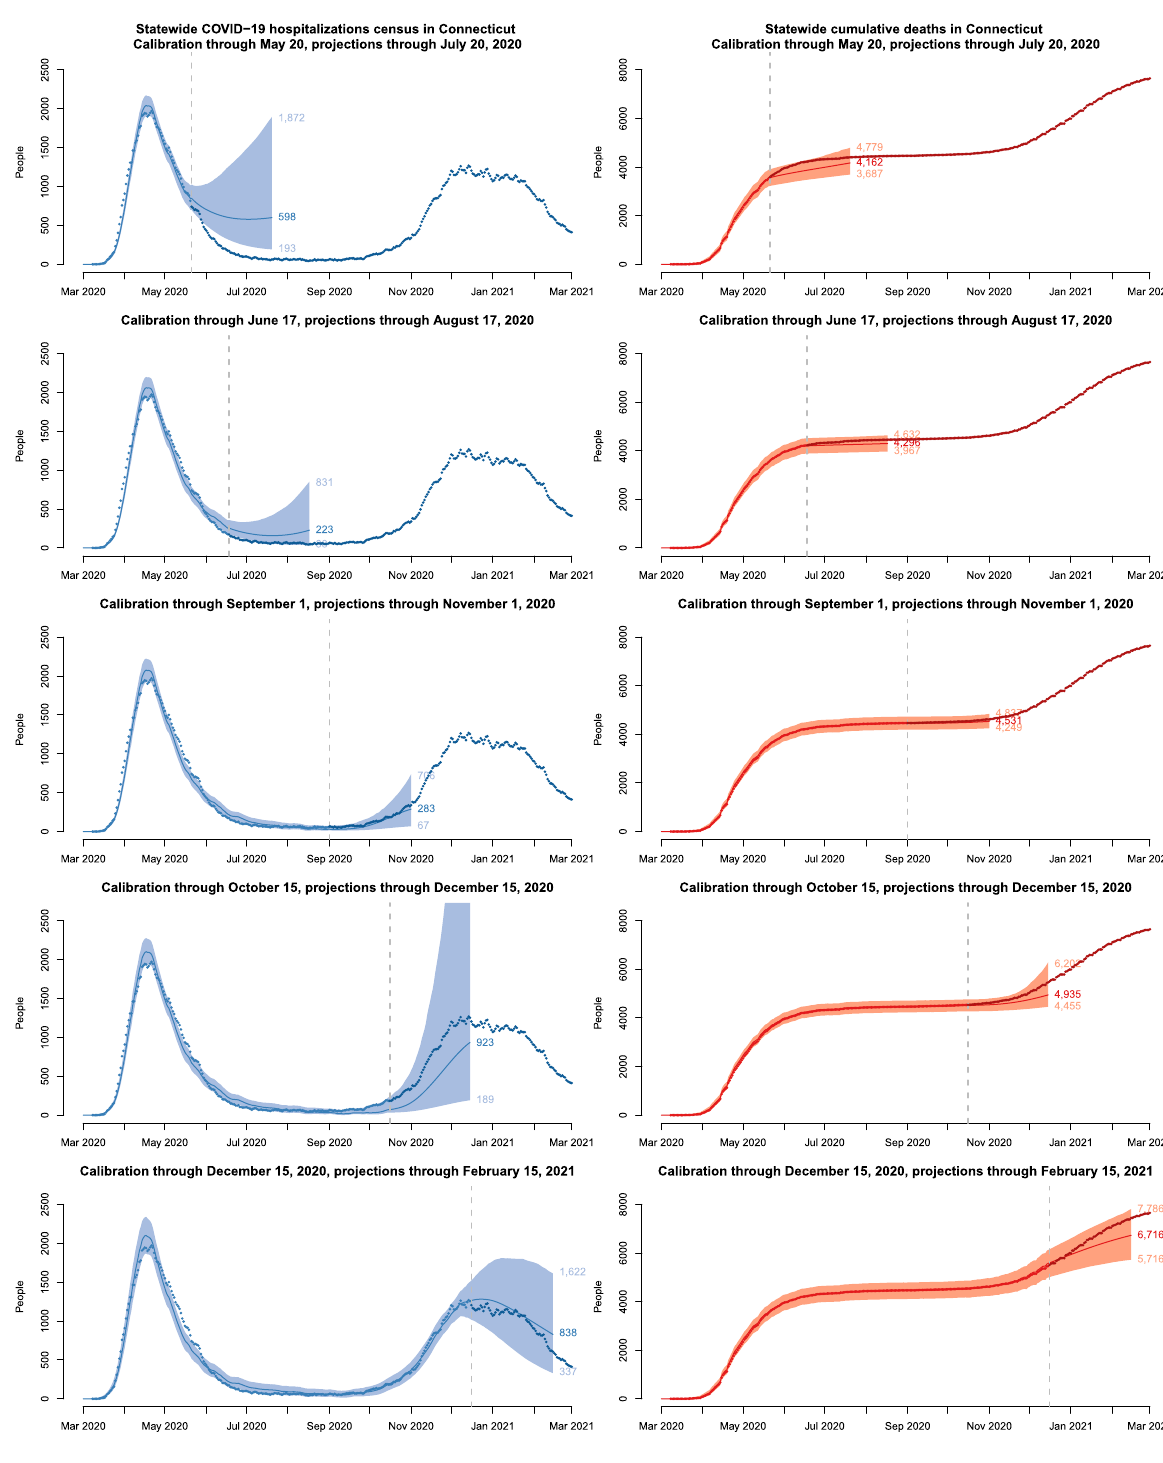
Figure 4. Posterior predictive performance of the transmission model calibrated using data up to the dashed line shown in each plot and projected forward for a period of two months. Solid lines represent model-projected means and shaded regions represent 90% posterior predictive intervals. Observed data are shown as points; lighter color points correspond to the data used in